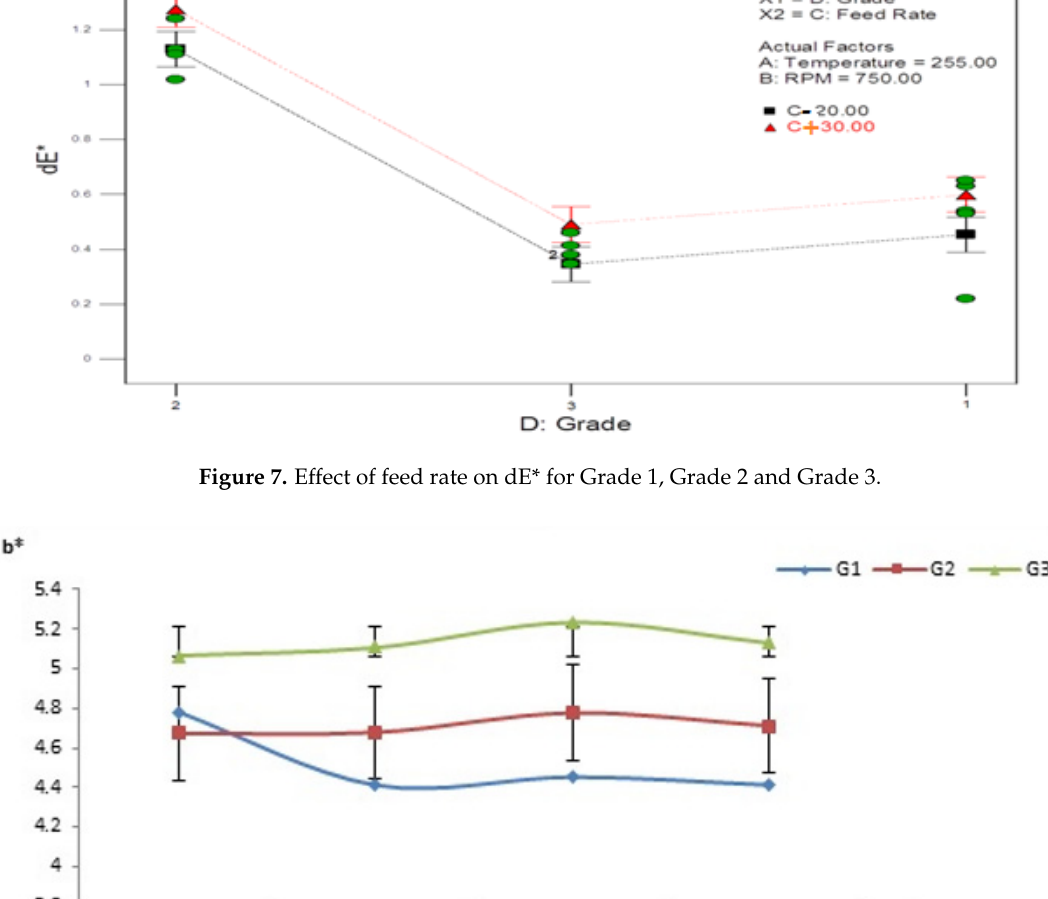
Figure 6. Interaction effect of Grade 1, Grade 2 and Grade 3.